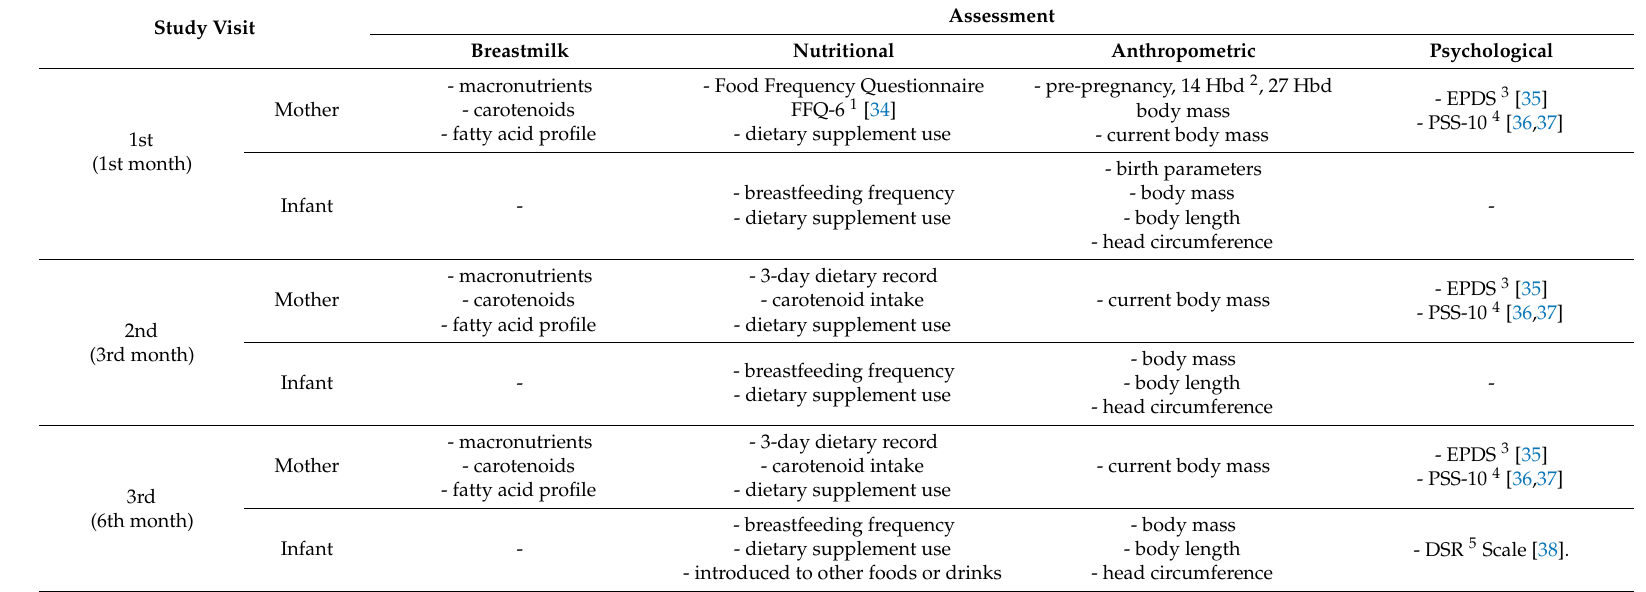
Table 1. Study design